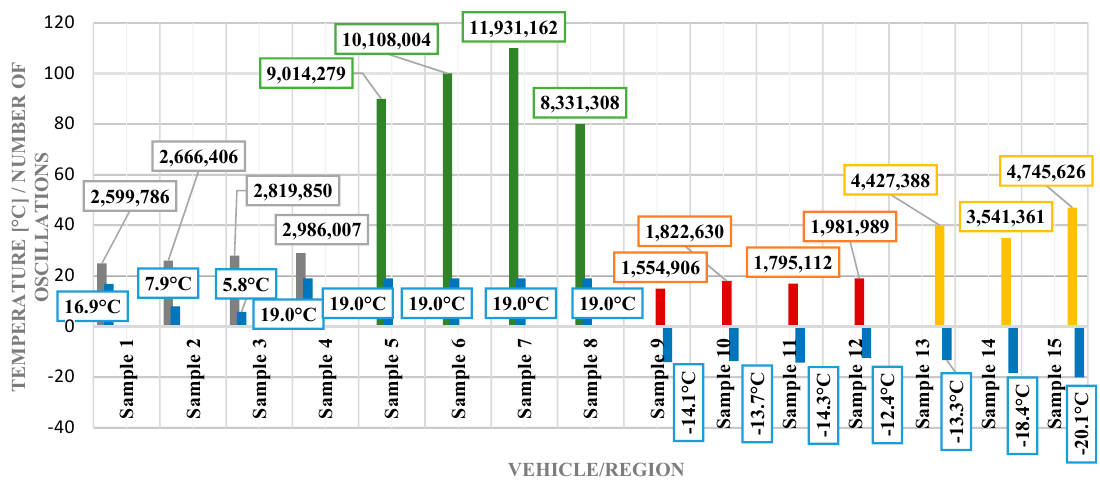
Figure 12. A chart of the obtained results for all tested samples.